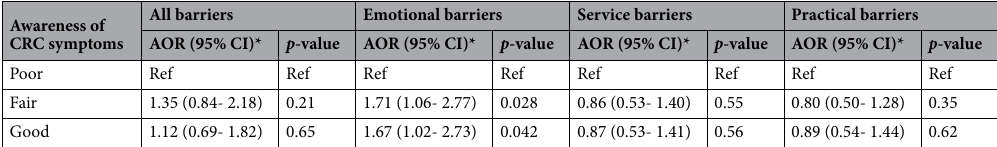
Table 6. Multivariable logistic regression analyzing the association between having at least the median number of barriers to seek medical advice for a possible colorectal cancer symptom and participant characteristics. AOR = adjusted odds ratio, CI = confidence interval, WBJ = West Bank and Jerusalem, CRC = colorectal cancer. All analyses were adjusted for age-group, gender, educational level, occupation, monthly income, having a chronic disease, following a vegetarian diet, knowing someone with cancer, marital status, residency, and site of data collection. The outcome in all models is binary with the median number of barriers in each category utilized as the cutoff. All p -values are for the multivariable logistic regression